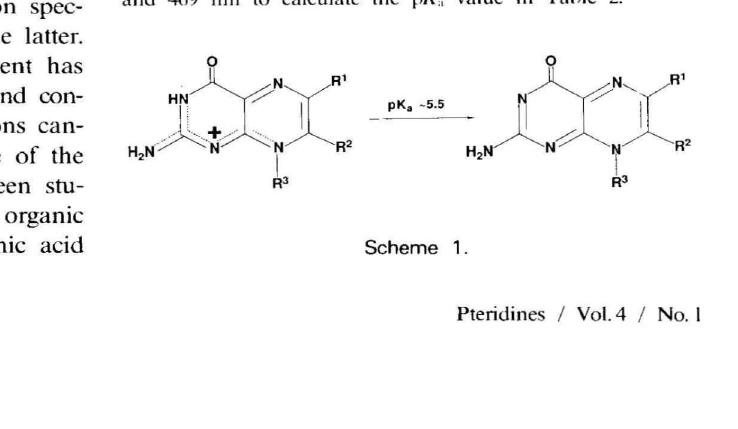
Figure 2. Excitation (a) and emission (b) spectra for the titra tion between pH 2 and ~ of the cation to neutral ionization of 8-propyl-pterin. Concentration is 1.7 )lM. X are spectral artifacts. Intensity values were fitted at 247. 260. 2~0. 310. 391 and 469 nm to calculate the pK, value in Table 2.